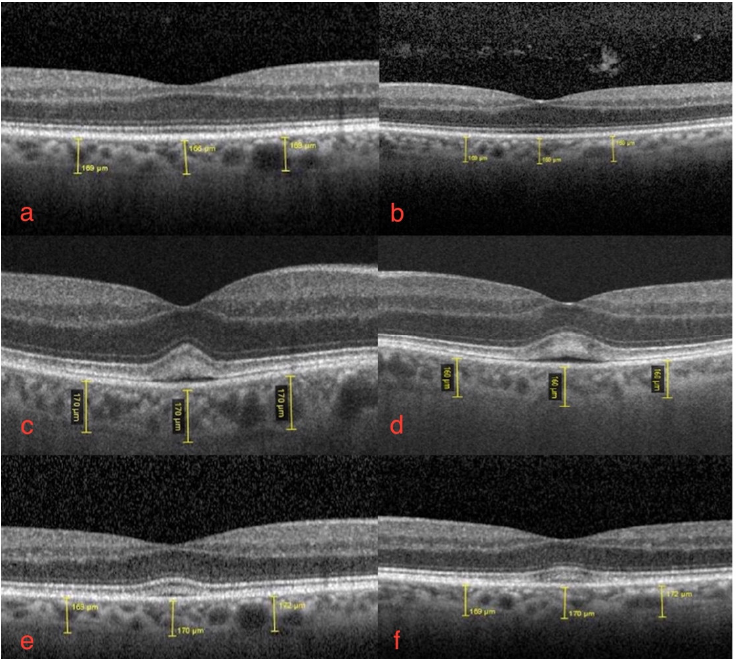
Figure 1. Macular optical coherence tomography of right ( a , c , e ) and left eye ( b , d , f ): ( a , b ) baseline right and left eye, normal foveal depression and no subretinal fluid; ( c , d ) bilateral FGFRAR at one- month follow-up from start of erdafitinib. Foveal serous neuro-epithelial detachment with thickening and high reflectivity of interdigitation zone, disruption of foveal contour with mild increase in central retinal thickening. No sign of increased ChT, no dilated choroidal vessels; ( e , f ) bilateral FGFRAR relapse at two-months follow-up from start of therapy: subclinical serous detachments with no change in choriocapillaris thickness. Conserved best-corrected visual